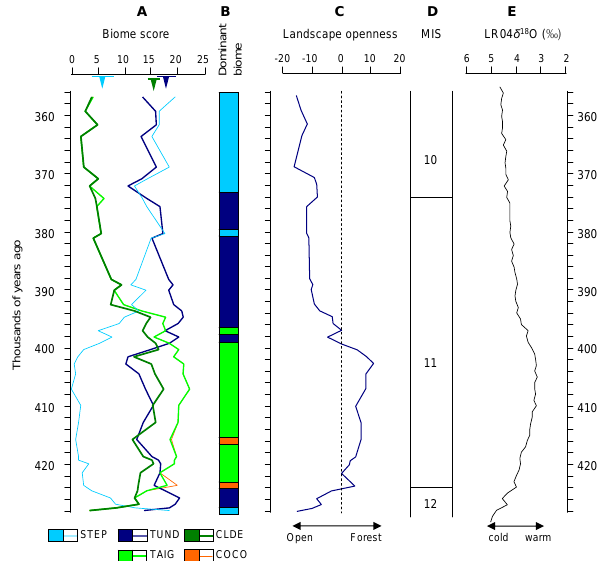
Fig. 5. Summary of paleoenvironmental trends between ∼ 428 and ∼ 356ka ago showing the (A) time series of individual biomes (tri- angles indicate the modern mean score of each respective biome; horizontal bars indicate the 95% uncertainty ranges); (B) dominant biomes; (C) characteristic of landscape openness calculated as the difference between the maximum score of forest biomes (MSFB) and the maximum score of open biomes (MSOB) at each level; and (D) marine isotope stage (MIS) boundaries and (E) stack of 57 globally distributed benthic δ 18 O records (after Lisiecki and Raymo, 2005). Biome names are abbreviated as follows: STEP – cold steppe, TUND – tundra, CLDE – cold deciduous forest, TAIG – taiga, and COCO – cool conifer forest. Note that TAIG and COCO biomes are not present in the modern regional vegetation, and there- fore their score is identical to CLDE in the modern spectra (see Prentice et al., 1996, and Sect. 2.3 for